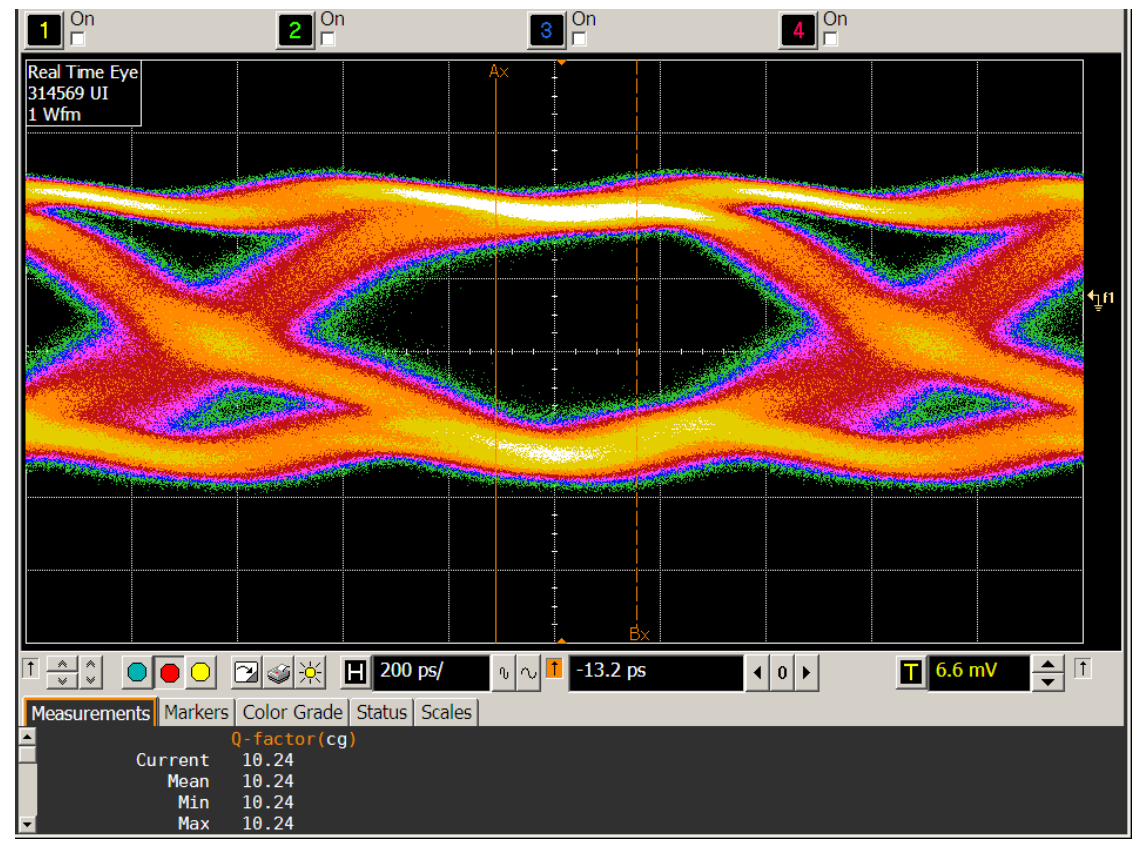
Figure 9. Eye diagram of received signal at 750